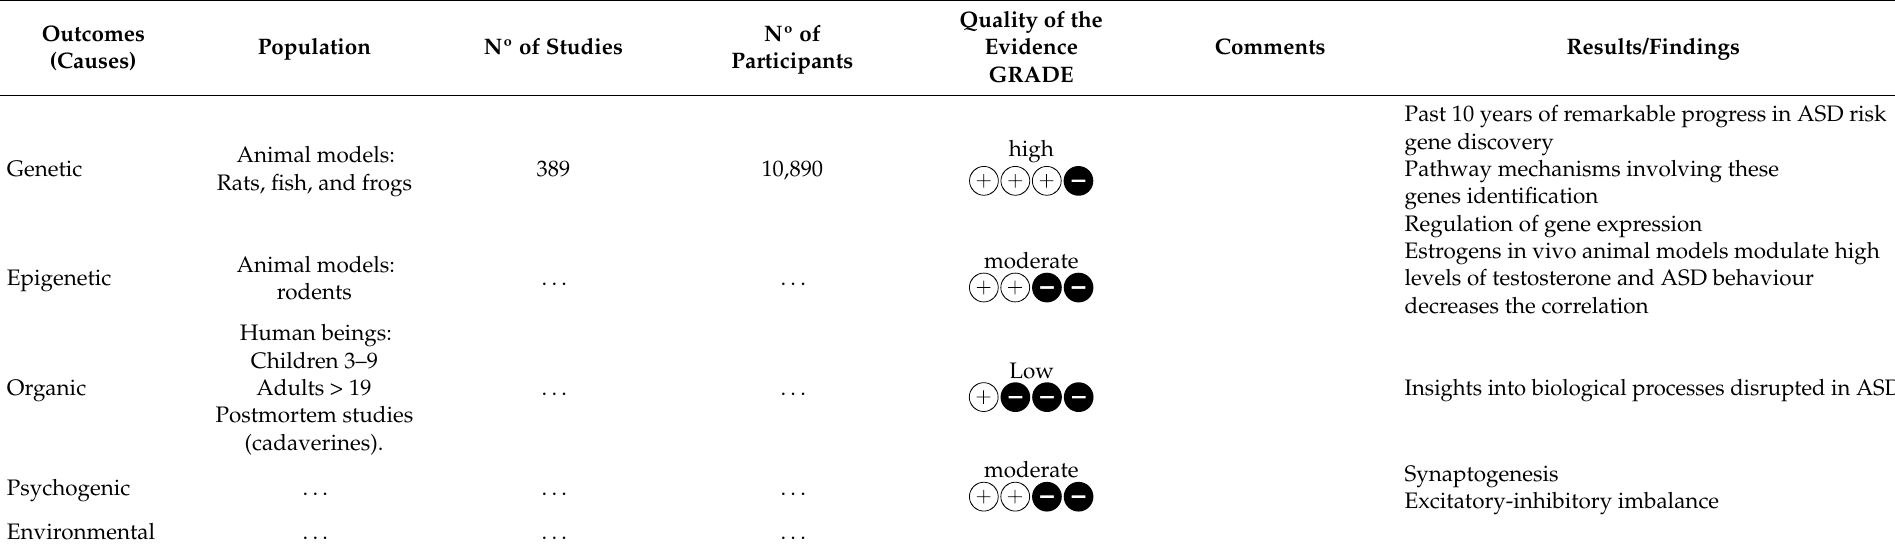
Table 2. Example of Summary of Findings (using GRADE). Population: ASD Issue: aetiology Outputs: Nº and rating of studies in each category T: last three years published papers (2020, 2021, 2022).